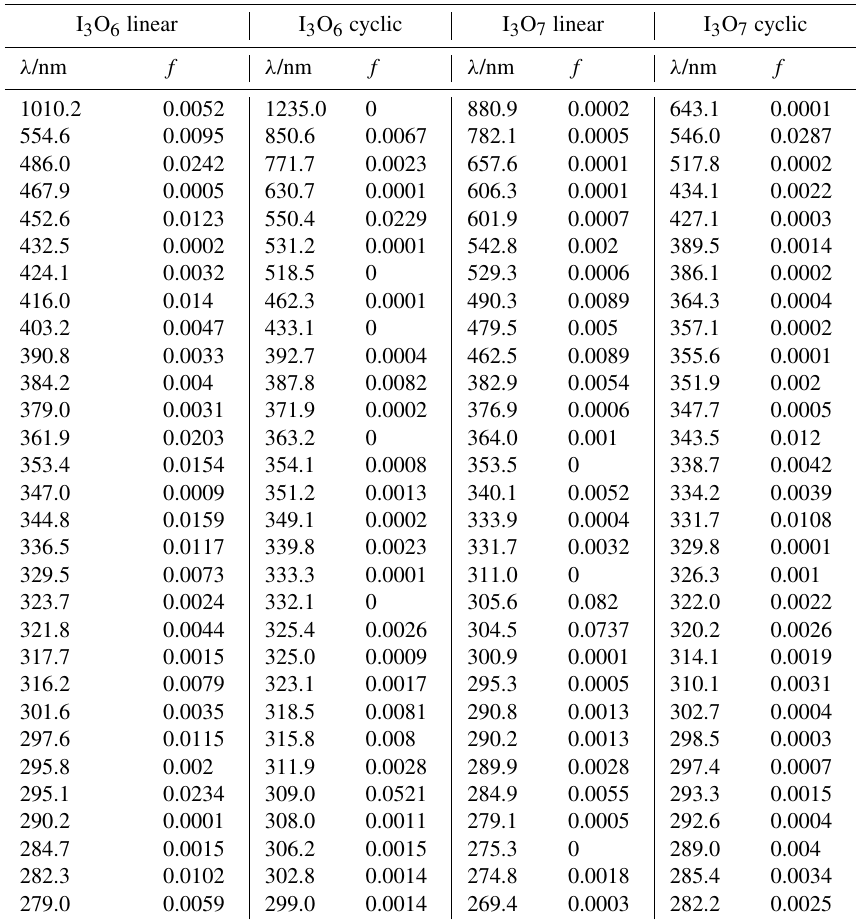
Table A4. Peak wavelengths and oscillator strengths ( f ) for the first 30 excited states of I 3 O 6 linear, I 3 O 6 cyclic, I 3 O 7 linear, and I 3 O 7 cyclic at the TD/B3LYP/G2 level of